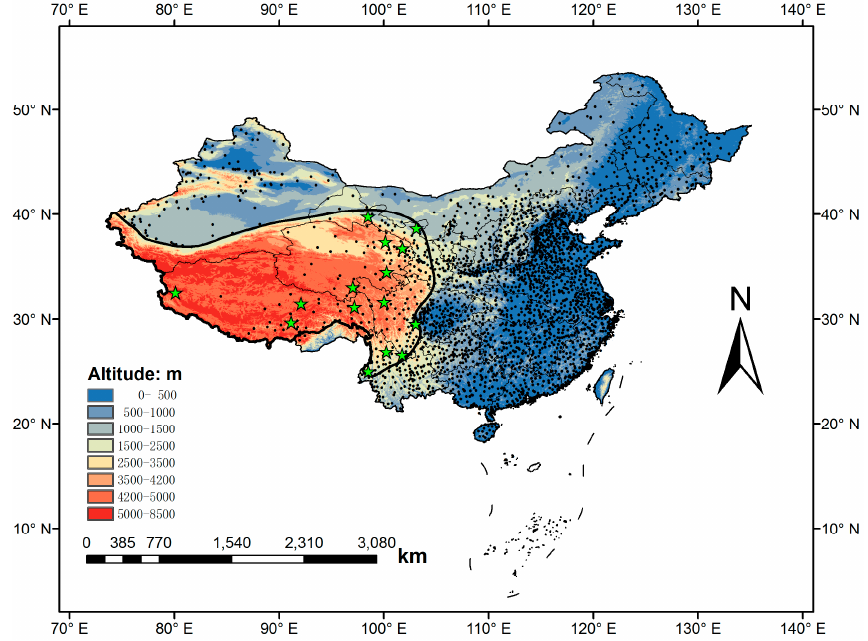
Figure 9. Distribution of solar radiation and weather stations. The black dots denote weather stations, and the five-point stars denote solar radiation stations used in this study. Table 7. Detailed information of solar radiation stations in this study. Station Latitude/N ◦ Longitude/E ◦ Altitude/m